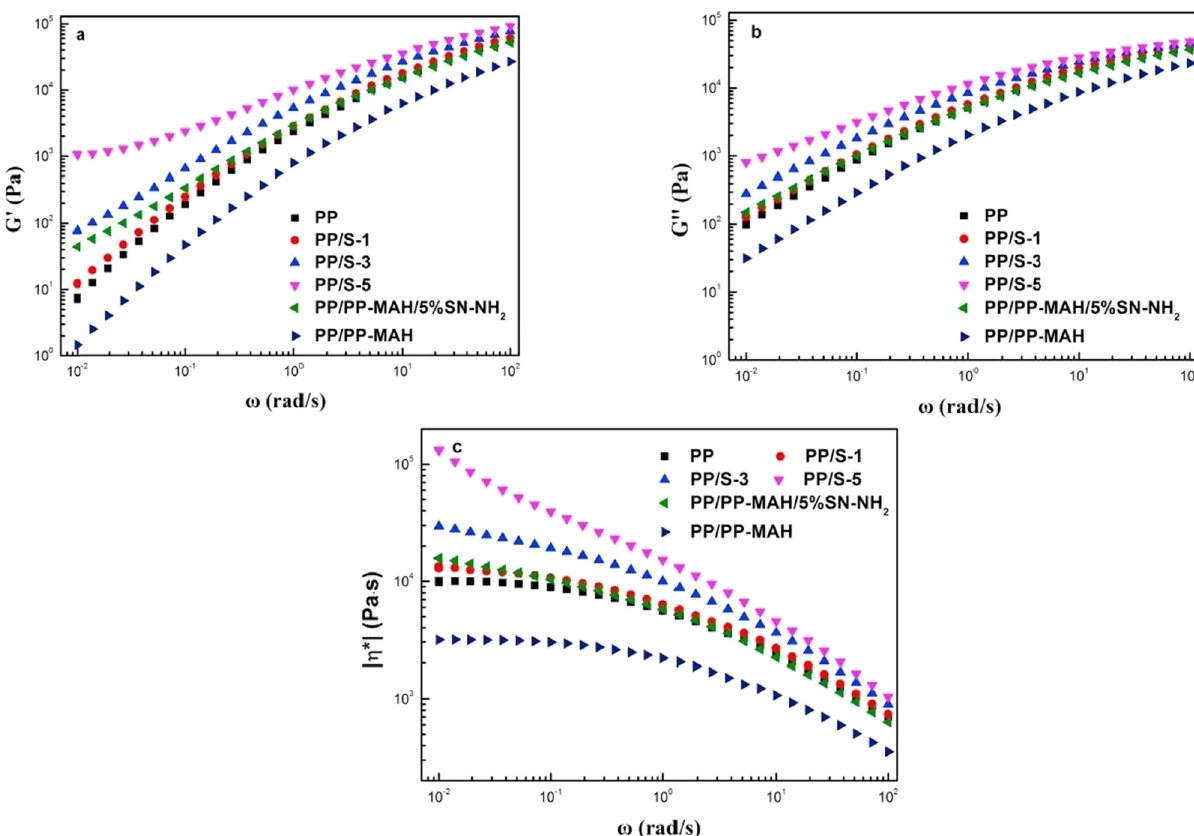
Figure 17: Frequency responses of ( a ) storage modulus ( G ′ ) , ( b ) loss modulus ( G ″ ) , and ( c ) complex viscosity (| η * |) for PP and PP